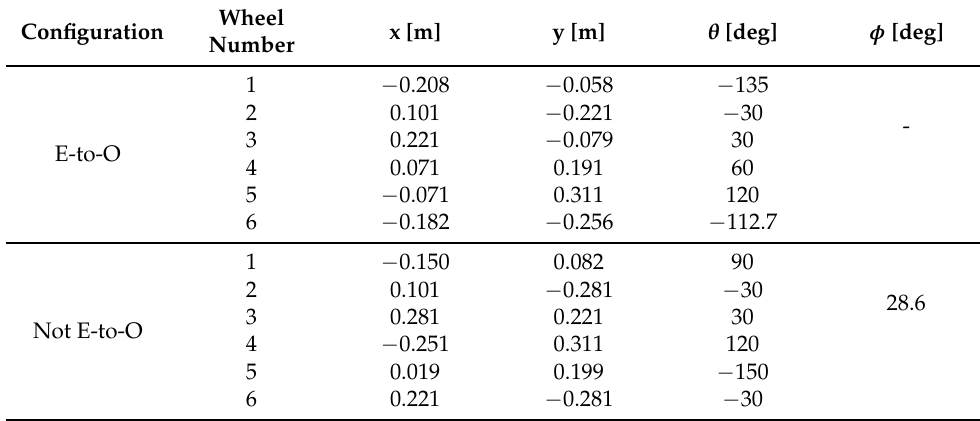
Table 3. Wheel arrangements of 6-wheeled Omni wheel